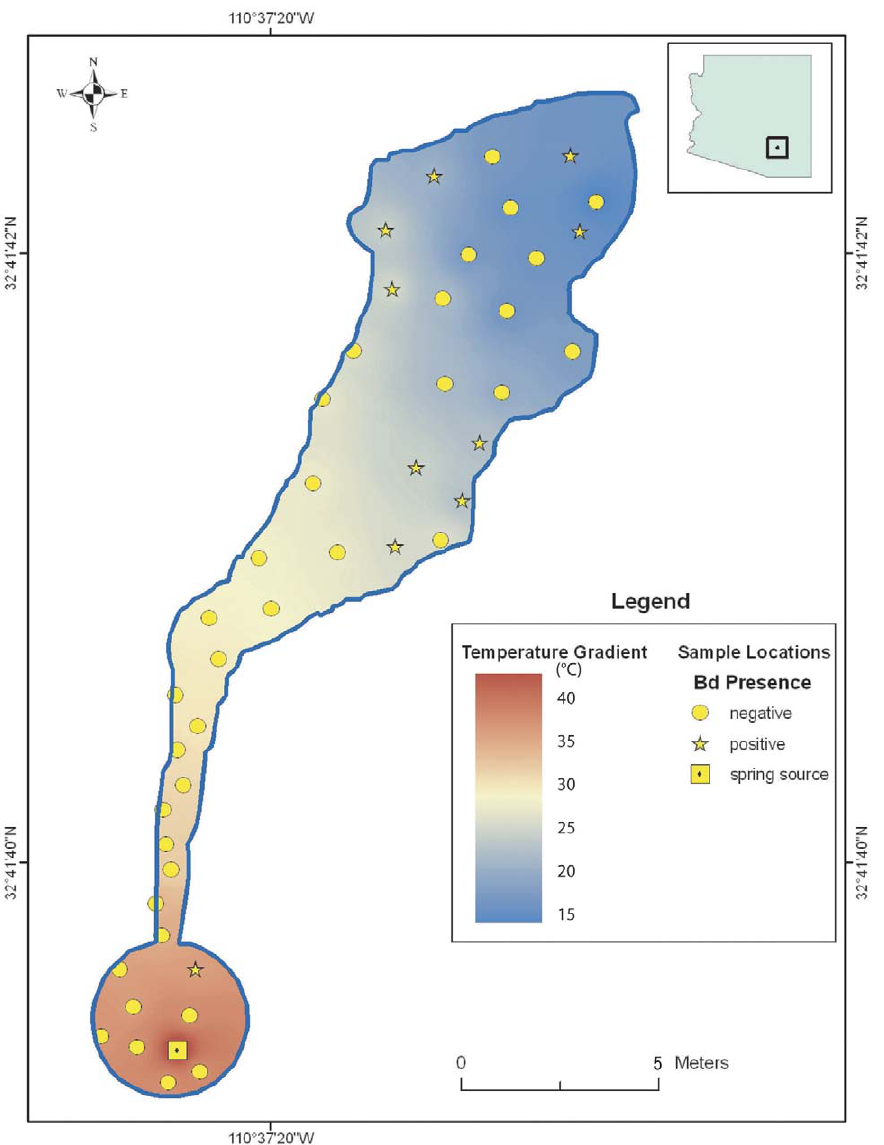
Figure 2. Schematic of Mammoth Hot Well showing approximate locations of amphibians and water temperatures. Symbols show approximate locations of lowland leopard frogs (redrawn from field notes) sampled in March 2009, their Bd infection status, and the range of measured water temperatures.